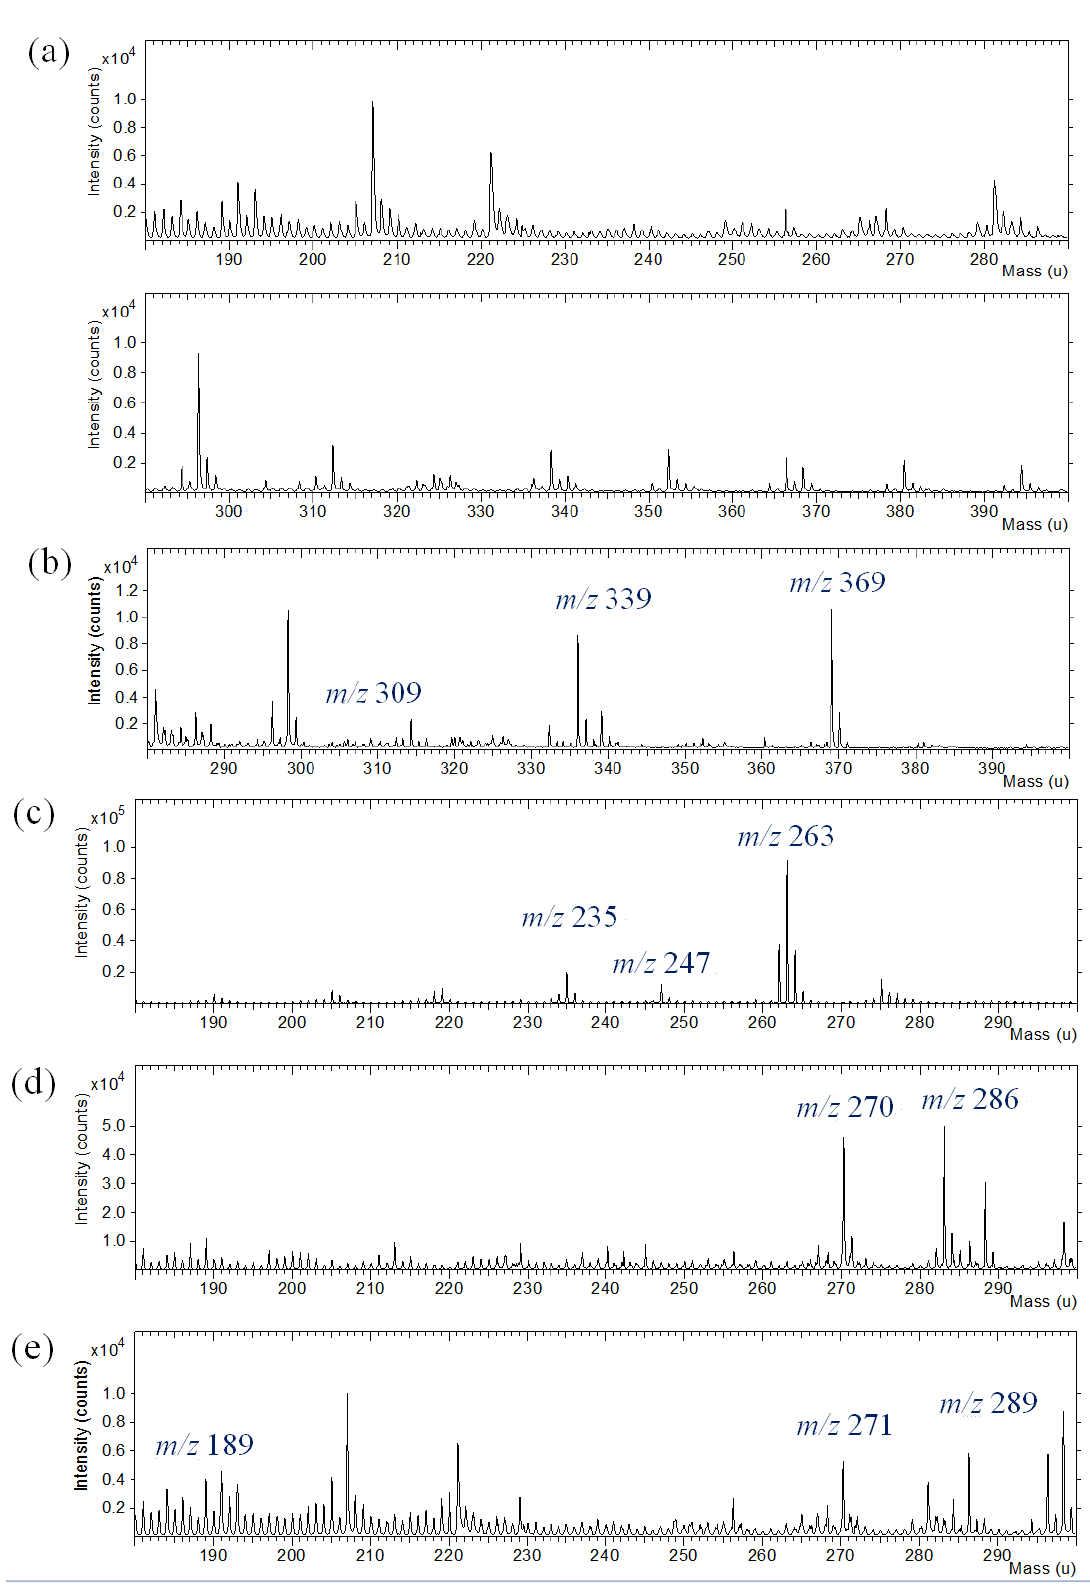
Figure 6. Positive ion TOF-SIMS spectra of silk fabric ( a ) undyed and dyed with commercial natural dyes: ( b ) curcumin; ( c ) indigo; ( d ) brazilin; ( e ) shikonin; ( f )